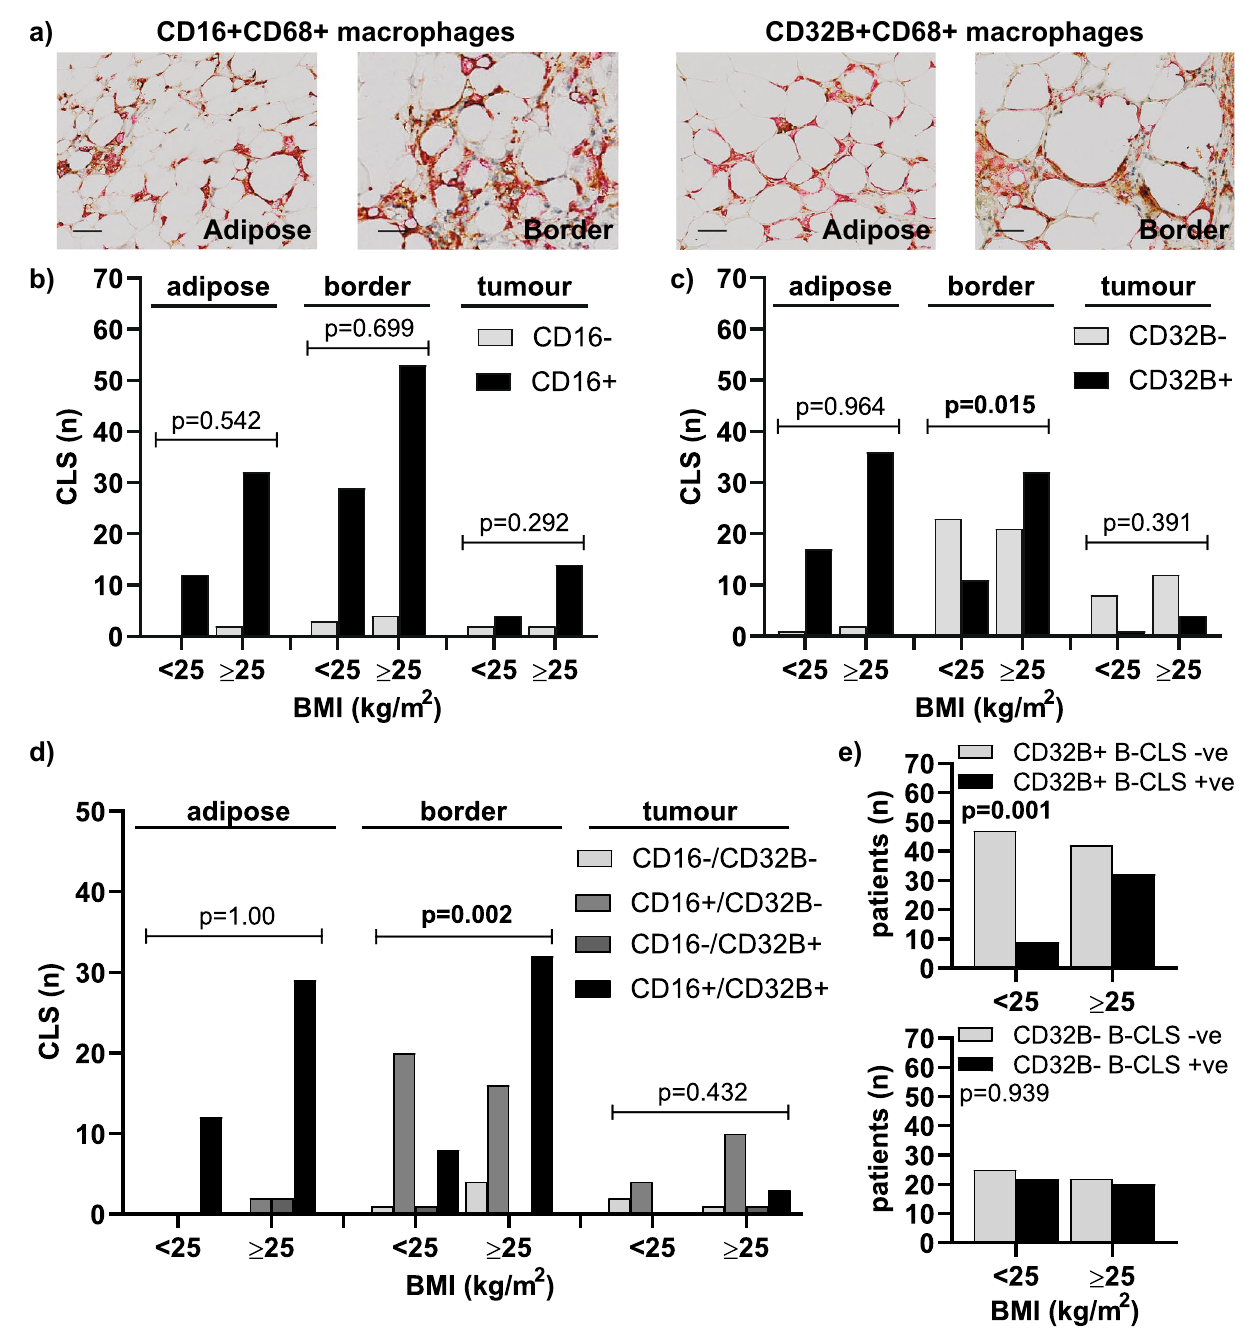
Figure 2. Macrophage phenotype within adipose tissue and at the adipose-tumour border stratified by BMI. ( a ) Representative images of CD16 + CD68 + and CD32B + CD68 + CLS within the adipose tissue and at the adipose-tumour border. Scale bar = 50 μm; Refine red, CD68; DAB, CD16 or CD32B; ( b ) Spatial distribution of CD16 + CD68 + and ( c ) CD32B + CD68 + CLS; ( d ) Co-expression analysis of CD16 and CD32B in CLS stratified by spatial distribution and BMI; ( e ) Association between CD32B + B-CLS (top) and CD32B- B-CLS (bottom) with BMI within the whole cohort. P values were calculated with Pearson’s Chi-square or Fisher exact test if one or more of cells had an expected frequency of 5 or